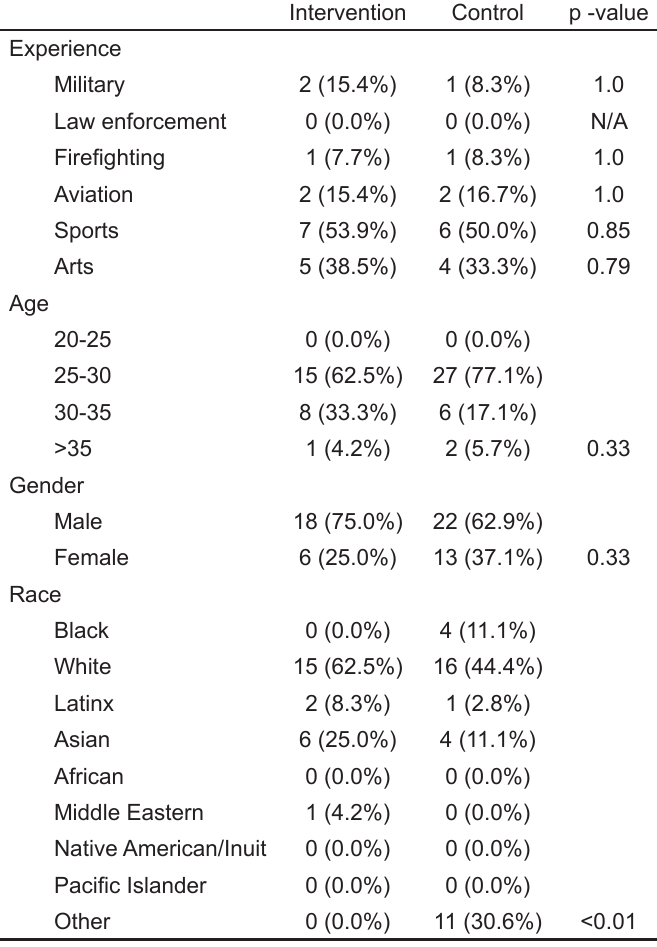
Table 1. Subject demographic data.